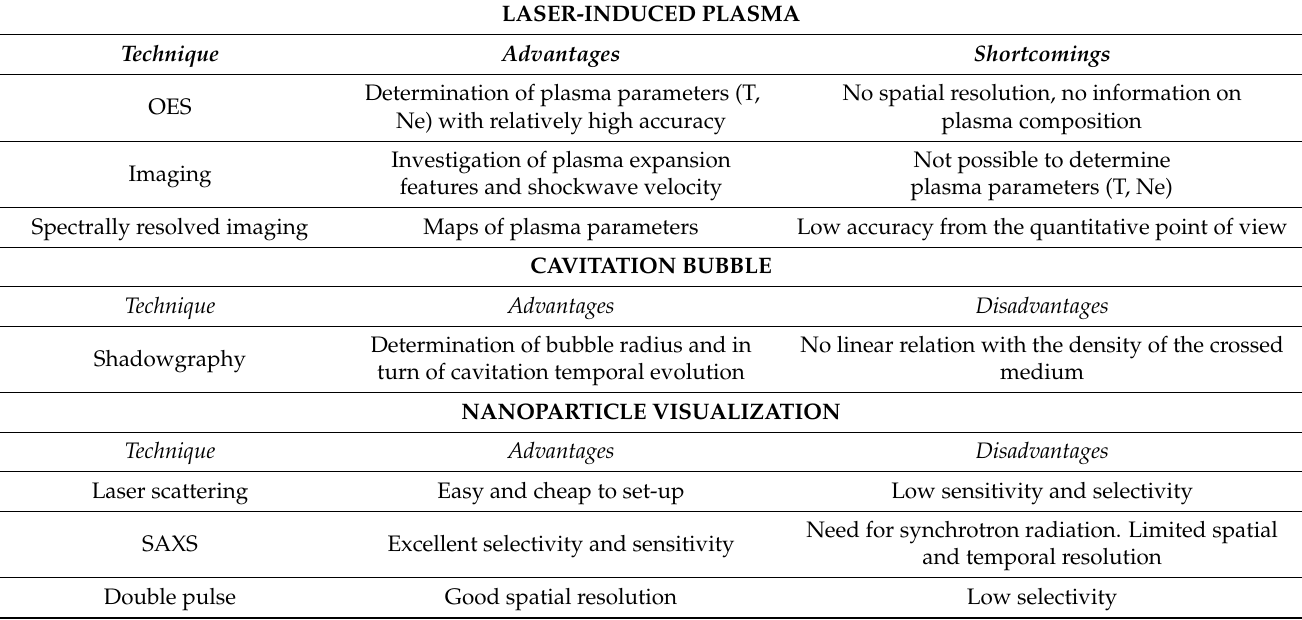
Table 1. Summary of the advantages and shortcomings of the various techniques applied in the different stages of the PLAL